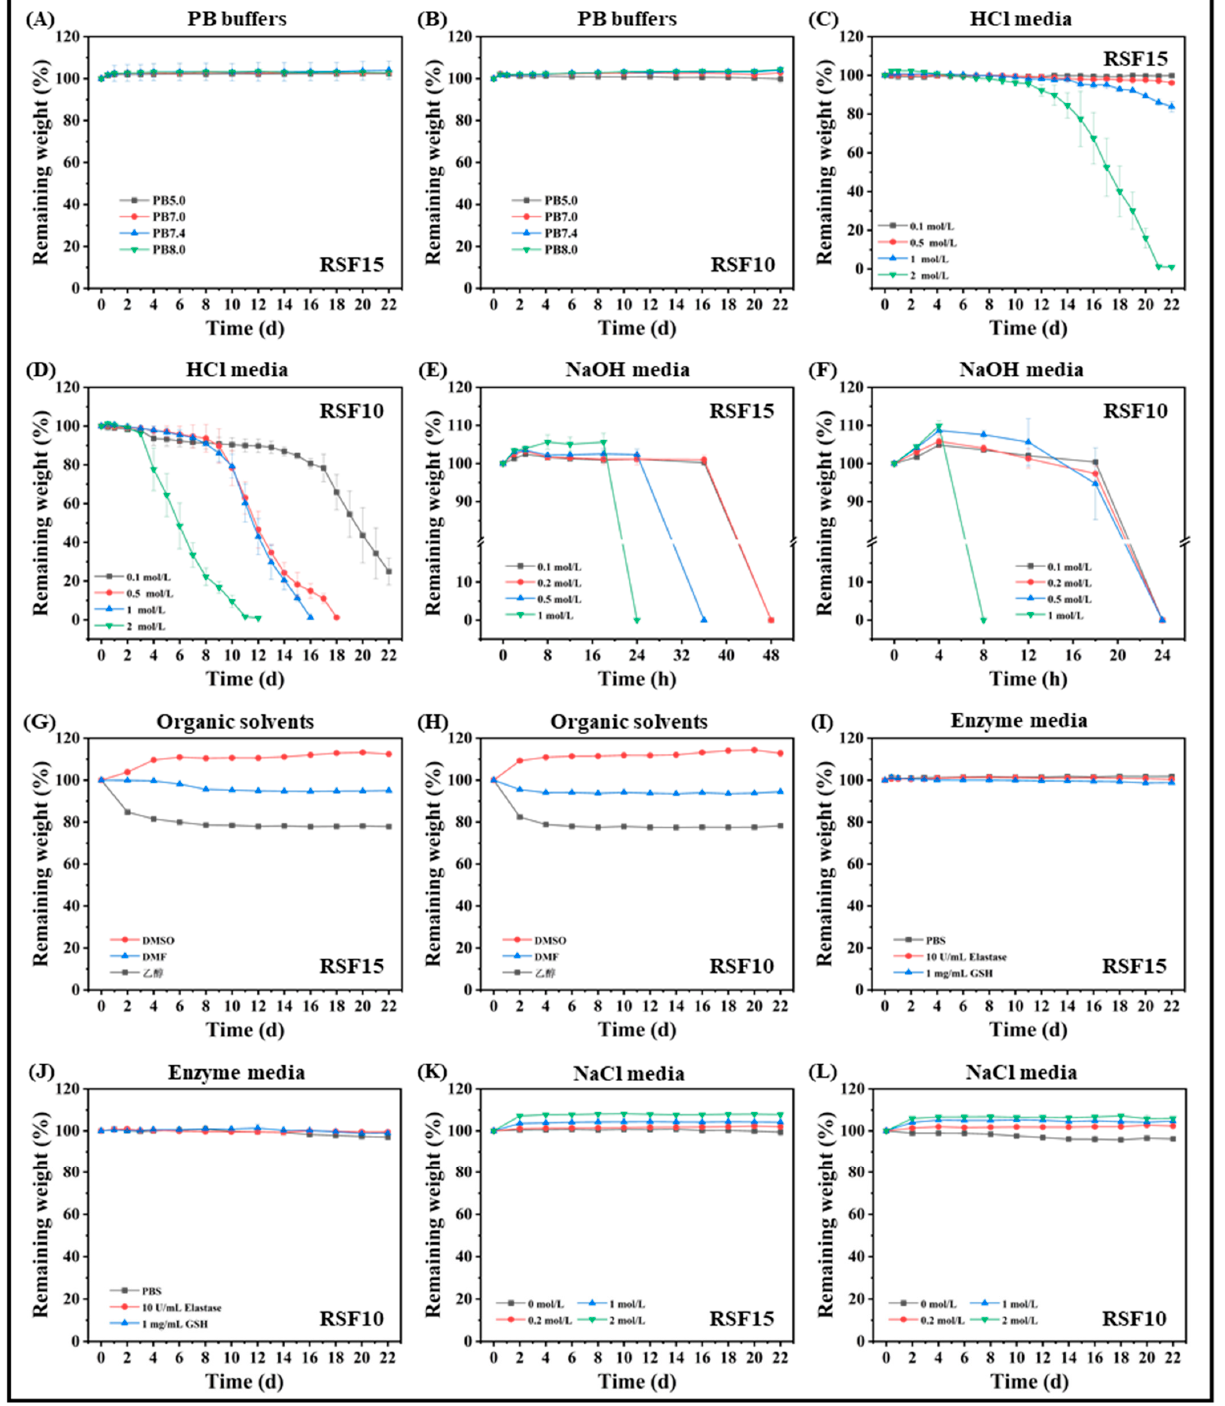
Figure 6. Degradation behaviors of silk fibroin hydrogels in different media. ( A , C , E , G , I , K ) were the hydrogels formed by the silk fibroin solutions with the final concentration of 15 mg/mL; ( B , D , F , H , J , L ) were the hydrogels formed by the silk fibroin solutions with the final concentration of 10 mg/mL. The freshly prepared silk fibroin aqueous solution was diluted to 30 and 20 mg/mL with ultrapure water. Then, the standby silk fibroin aqueous solution was mixed with PBS buffer at a volume ratio of 1:1 and shaken to obtain silk fibroin solutions of 15 and 10 mg/mL, denoted as RSF15 and RSF10, respectively, and placed in a 37 °C incubator for static incubation to form hydrogels. These were used to study the degradation behavior in different media.